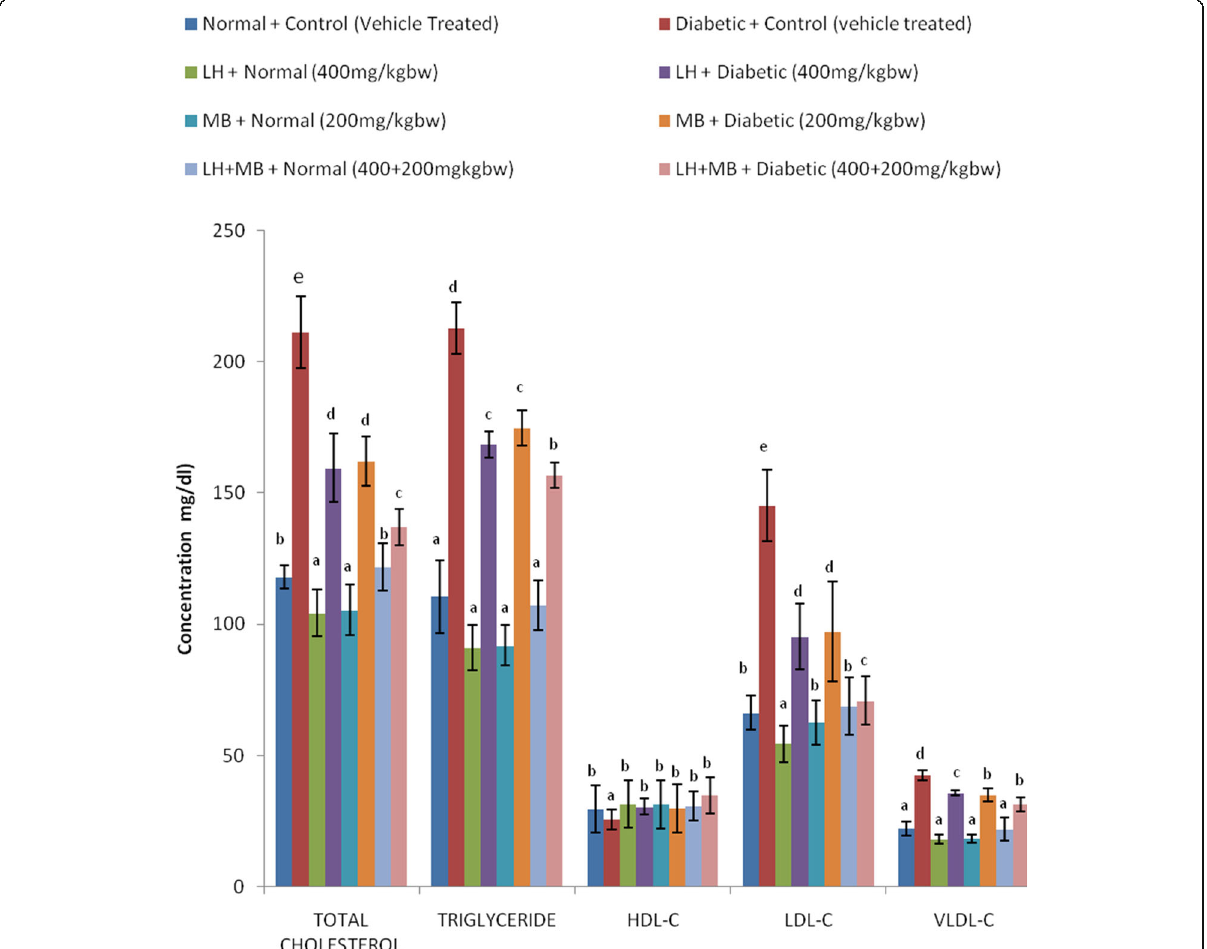
Fig. 1 Effect of aqueous leaf extracts of L. hastata , M. balsamina and their combination on lipid profile of normal and STZ-induced diabetic rats. Values expressed are means with their Standard Deviations represented as error bars for six animals per group. Different superscripts a – d for each parameter indicate statistical significance at value of P < 0.05 (Tukey ’ s post hoc